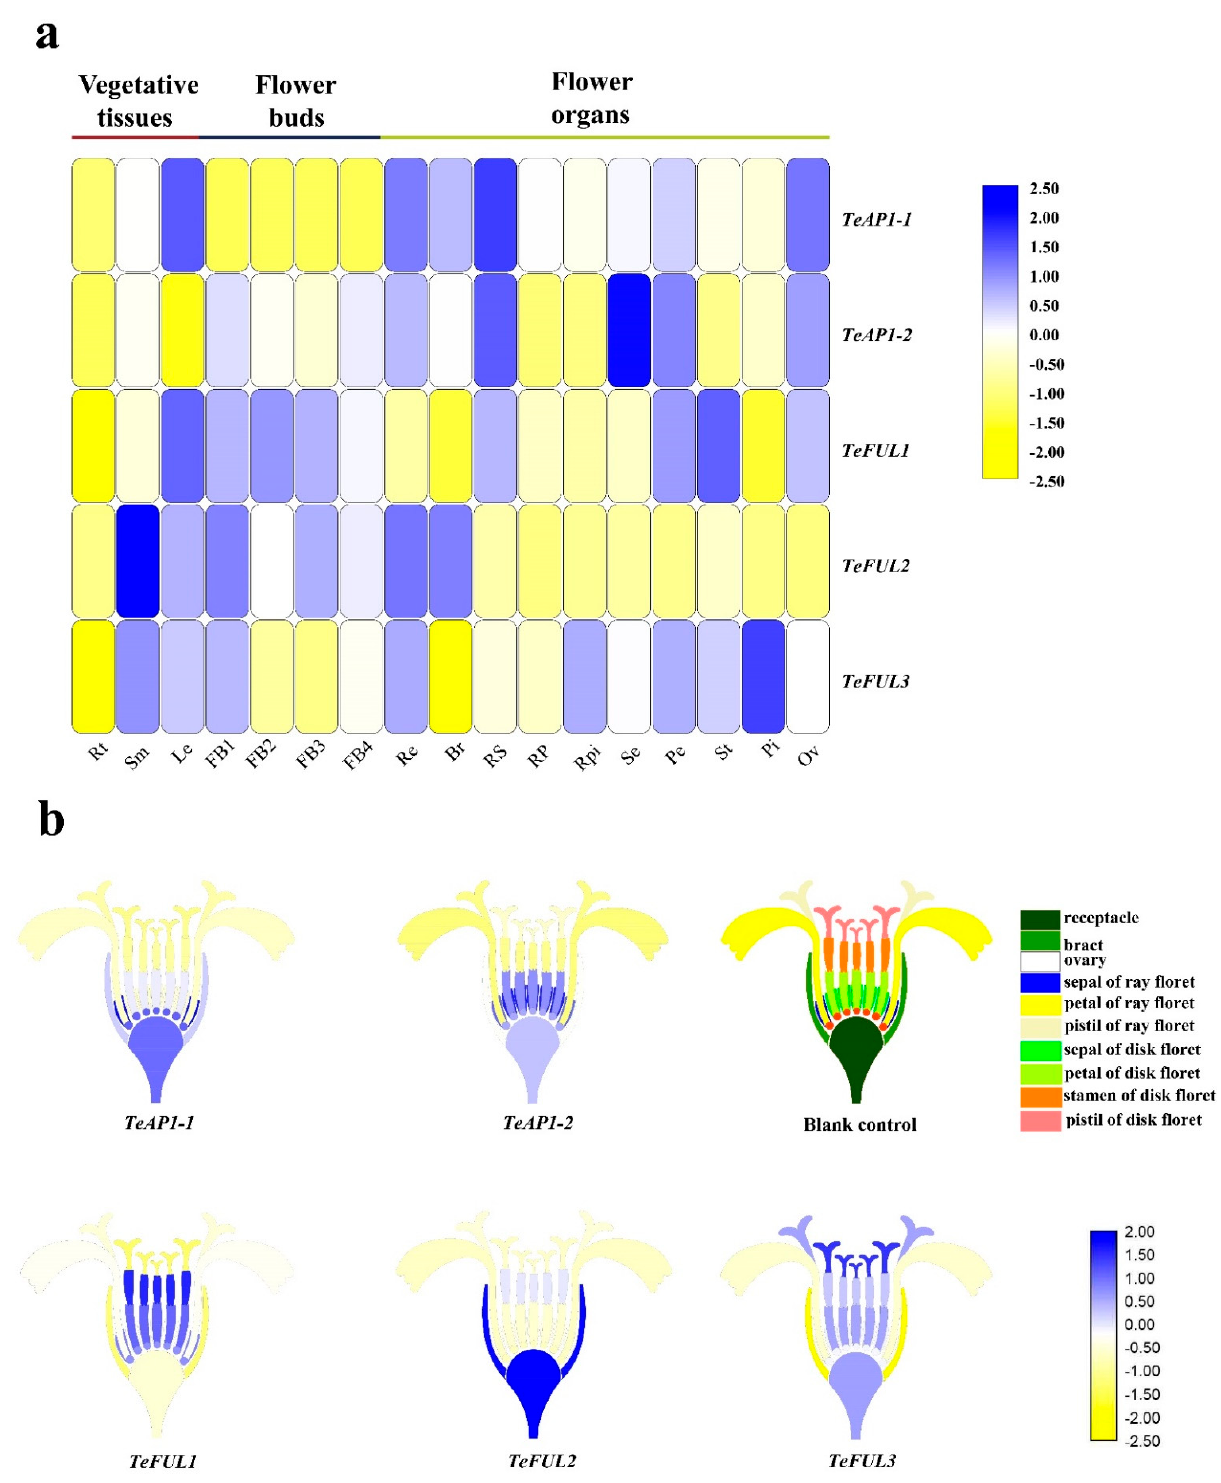
Figure 3. Expression levels of TeAP1/FUL genes in different tissues and organs of marigold. ( a ) Heatmap of relative expression of TeAP1/FUL genes by qRT-PCR in different tissues and organs. Rt: root; Sm: stems; Le: leaves; FB1-FB4: flower buds were 0–1, 2–3, 4–5 and 6–7 mm in diameter, respectively; Re: receptacle; Br: bract; RS: sepal of ray floret; RP: petal of ray floret; RPi: pistil of ray floret; Se: sepal of disk floret; Pe: petal of disk floret; St: stamen of disk floret; Pi: pistil of disk floret; Ov: ovary. ( b ) Heatmap of TeAP1/FUL genes in the inflorescence of marigold based on the relative expression by qRT-PCR. Blank control: structural model of capitulum in marigold; different colors represent different floral organs.